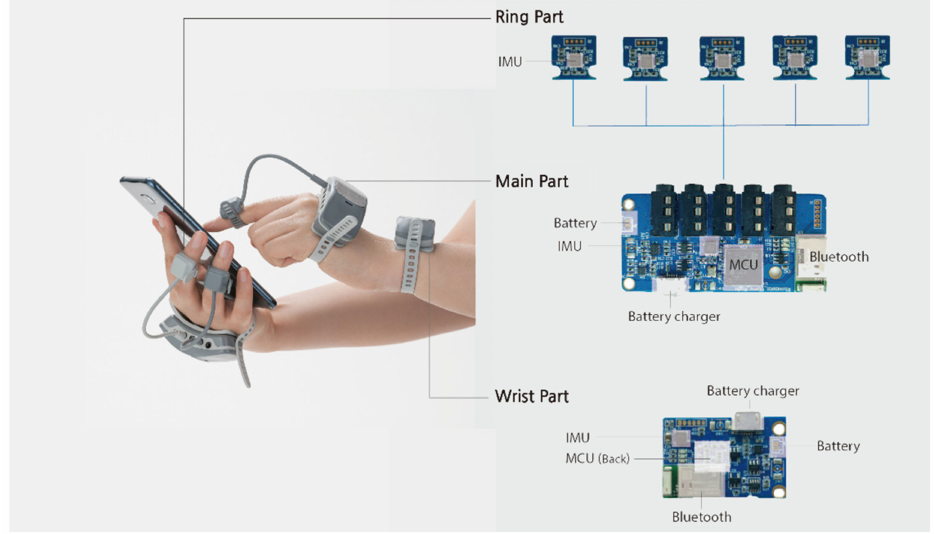
Figure 1. Wearable inertial measurement unit(IMU) system for collecting hand movement data during object